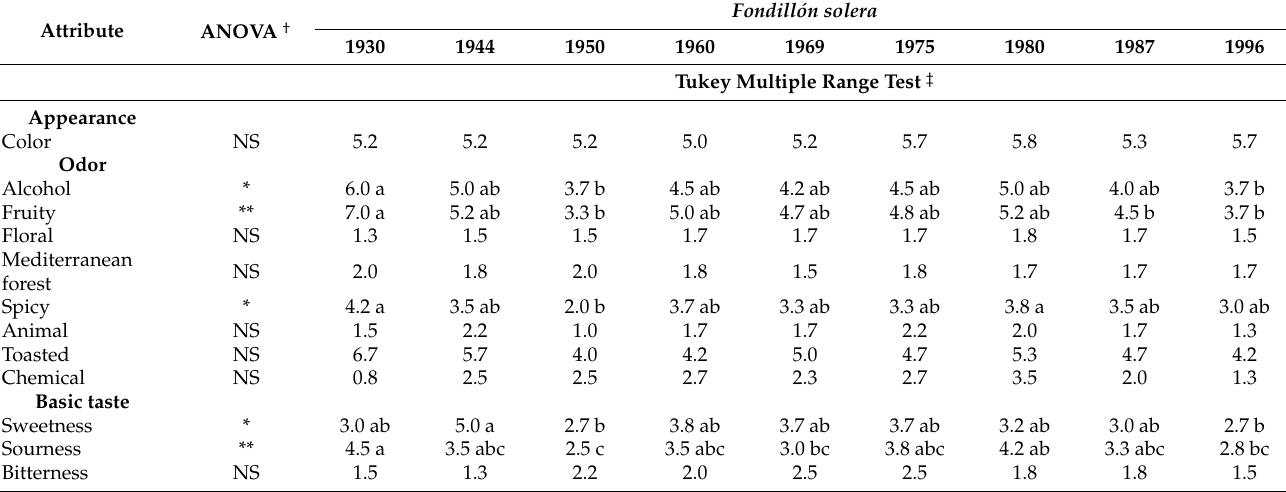
Table 4. Descriptive sensory analysis of wines aged in Fondill ó n wines as affected by the “ solera ”